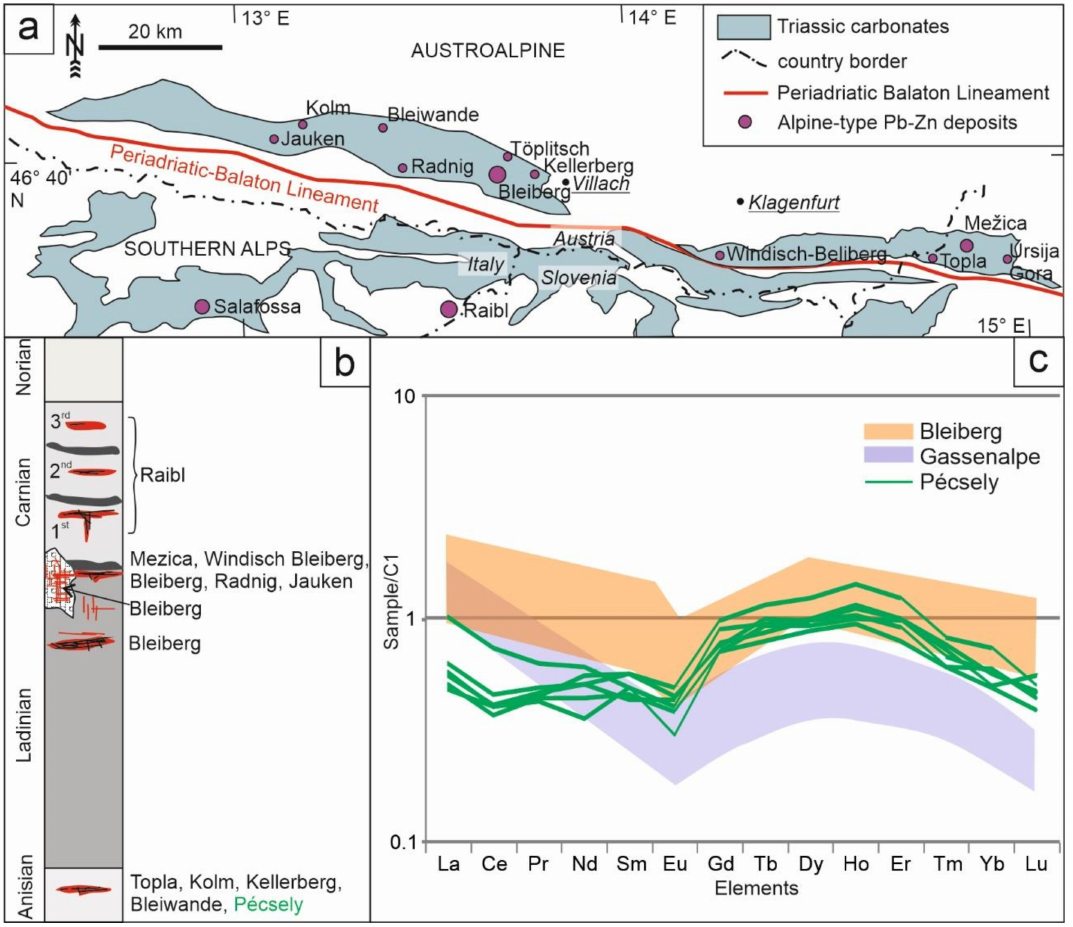
Figure 10. ( a ) Simplified geological map of the Drau Range after [18,52] showing the positions of the major Alpine-type Pb-Zn deposits; ( b ) schematic profile showing the positions of the ore-horizons (red lines) in the different stratigraphic niveous (modified after [53]); ( c ) comparison of the REE content of fluorite from P é csely with Alpine occurrences